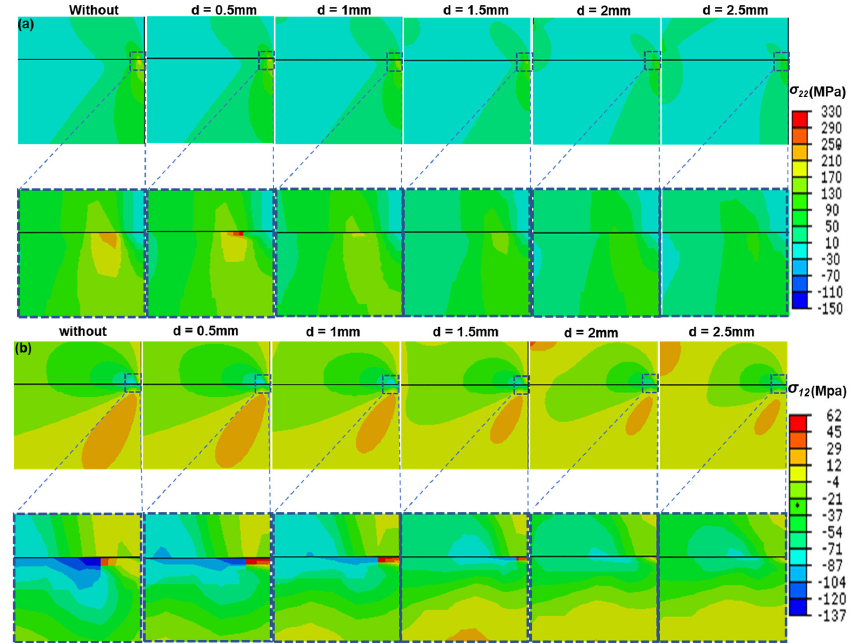
Figure 5. Variation of stress field: ( a ) σ 22 and ( b ) σ 12 at crack tip for different depths of 3 mm thickness of TC with two vertical cracks.